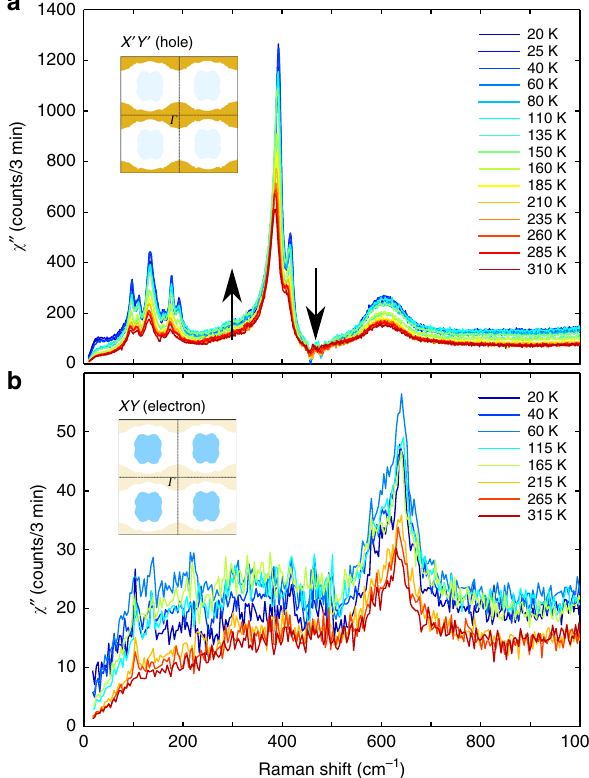
Fig. 2 Symmetry-dependent Raman spectra. a Raman spectra ( χ ″ ( ω )) in X 0 Y 0 at several temperatures. The arrows indicate spectral weight loss and gain above and below the phonon modes ~400 cm − 1 , respectively. b The corresponding plot in XY at a few